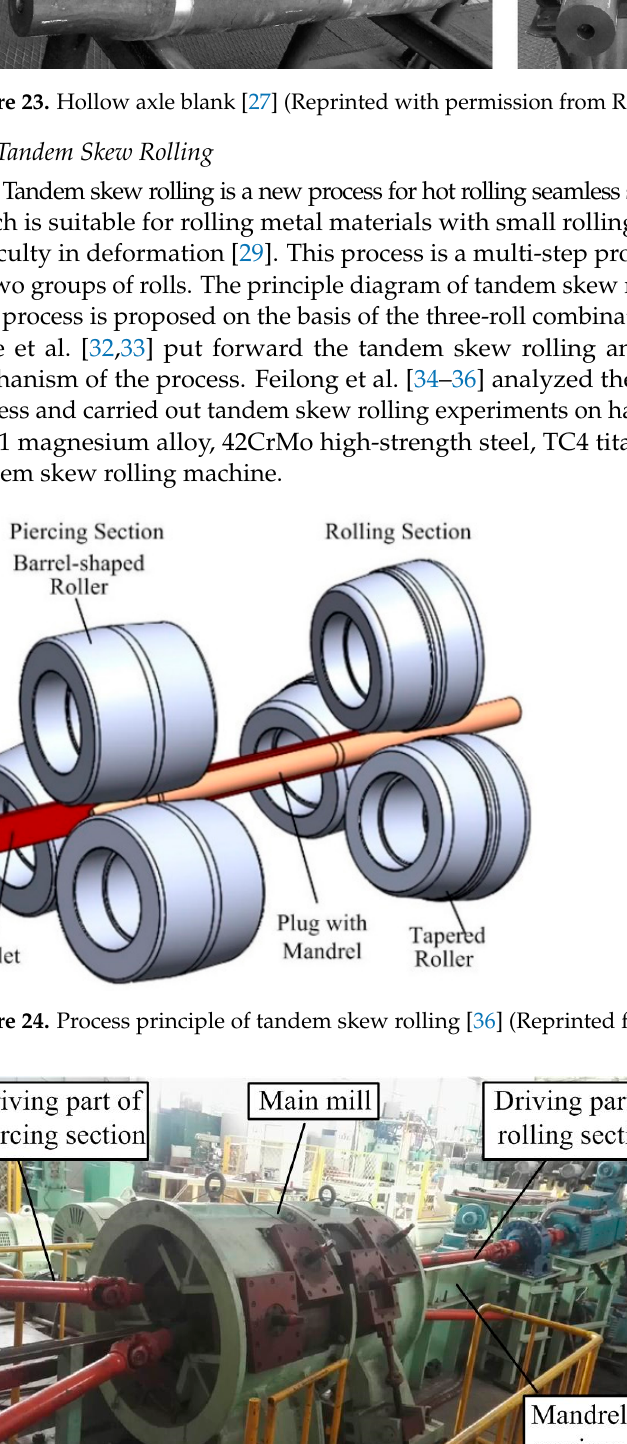
Figure 22. Forming inner hole of hollow axle by rotary piercing: ( a ) rolling mill; ( b ) billet piercing process; ( c ) steel pipe [26] (Reprinted with permission from Ref. [26]. 2023, Springer Nature).